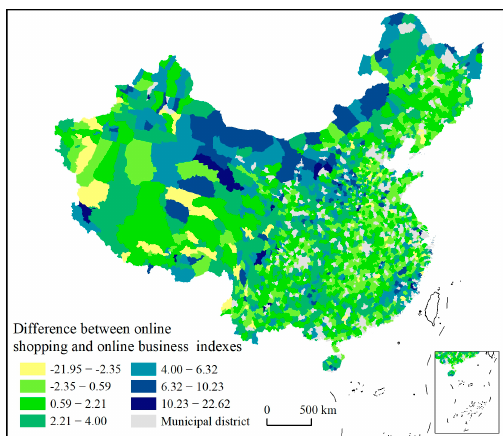
Figure 3. County-level differences in online business and online shopping indexes in 2015.